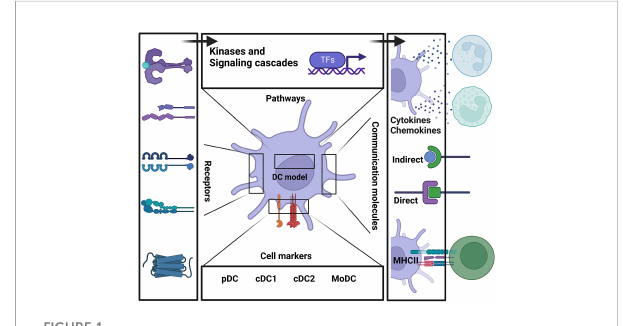
FIGURE 1 Schematic representation summarizing the main components of the model and the connection between each biological layer of the